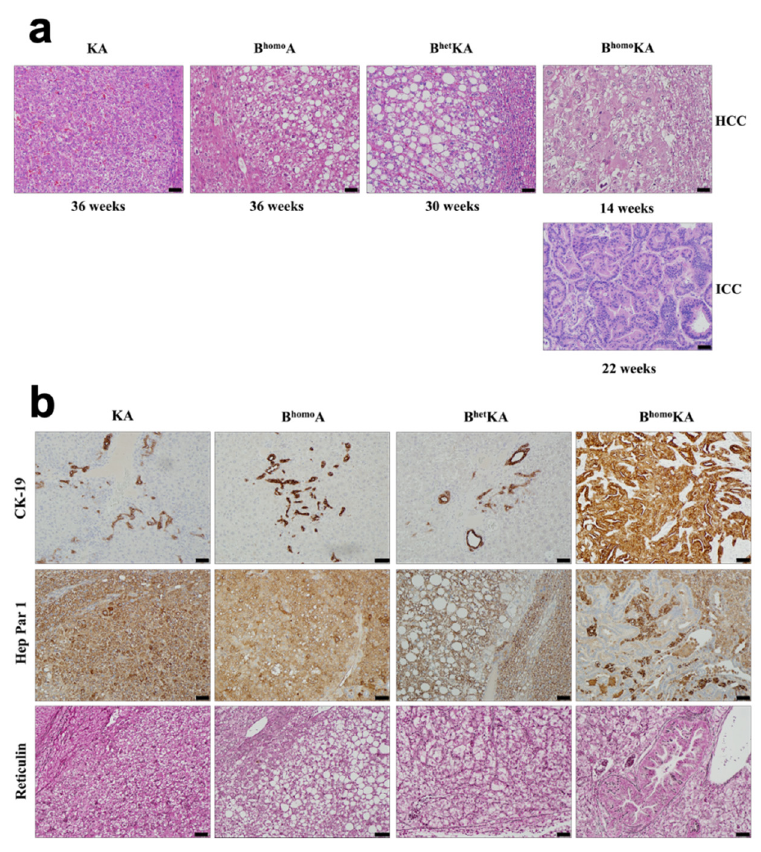
Figure 2. GEMM experimental cohorts have distinct histologic phenotypes. ( a ) KA, B homo A, and B het KA mice exhibit HCC only by H&E, while B homo KA mice have both ICC and HCC lesions; ( b ) CK-19, Hep Par 1, and reticulin staining demonstrates HCC lesions in all cohorts and both HCC and ICC in B homo KA mice. CK19 highlights normal ducts in KA, B homo A, and B het KA mice, while ICC foci are strongly positive in B homo KA mice. Conversely, Hep Par 1 stains positive among HCC foci in KA, B homo A, and B het KA mice, as well as in HCC foci of B homo KA mice; however, it is negative in ICC foci of the latter. Reticulin highlights abnormal architecture in the HCC of all four mouse genotypes. Images were taken with 200× magnification. Scale bar is 50 μ m.